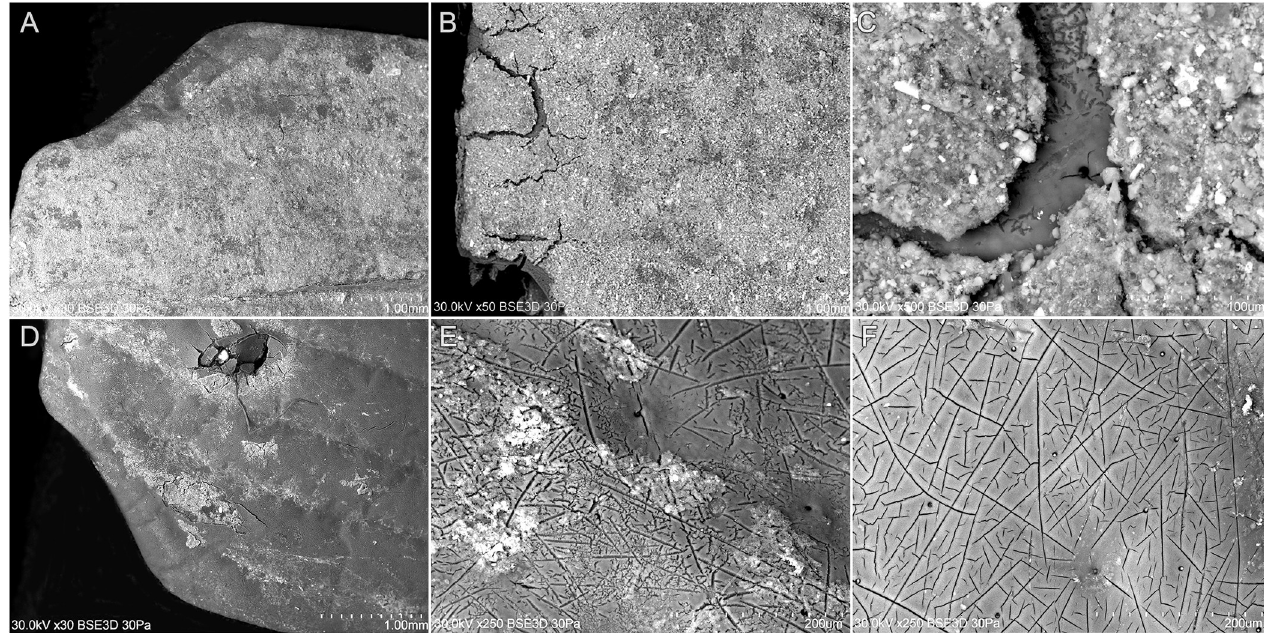
Fig 6. SEM imaging of Geotrupes stercorarius insect remains from the urn originating from burial 506. Right elytron covered with sediment (A, B, C), left elytron with sediment cleaned off (D, E) and the surface structure of the elytron of the modern reference insect (F).